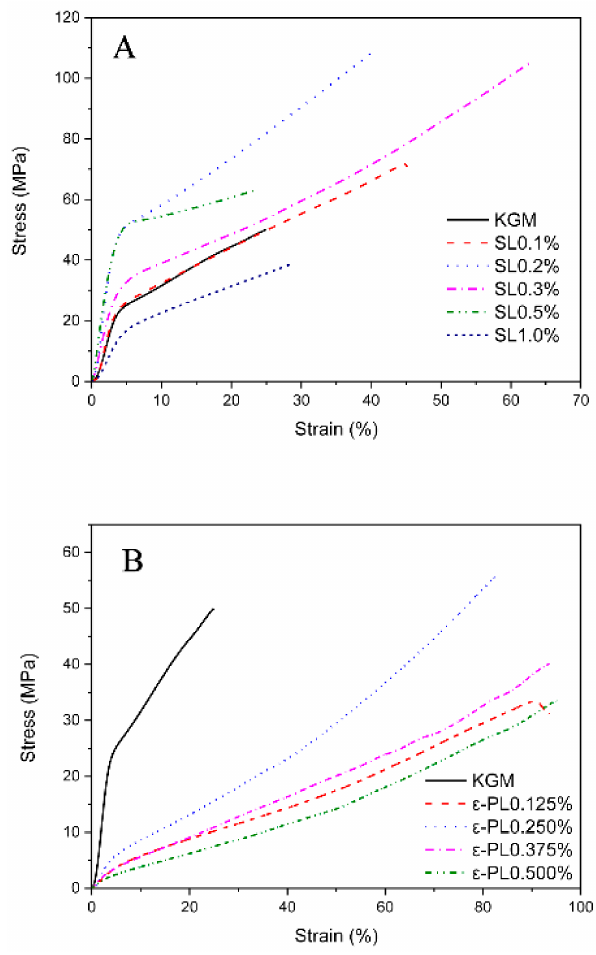
Figure 2. The stress–strain curves of the KGM/SL ( A ), KGM/ ε -PL ( B ), KGM/SL/ ε -PL ( C ) films with different